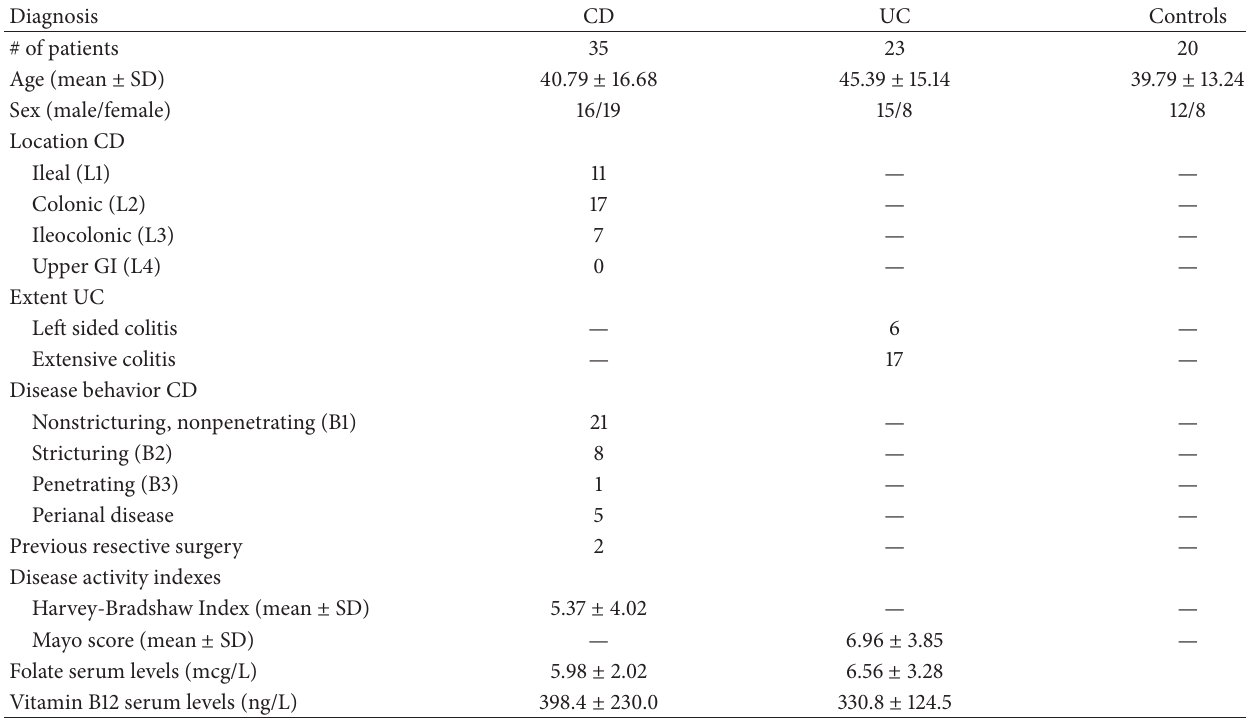
Table 1: Demographic and clinical characteristics of enrolled IBD